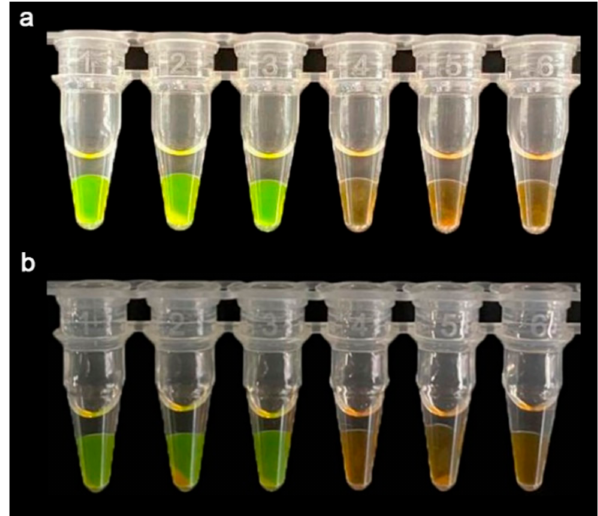
Figure 10. Loop-mediated isothermal amplification (LAMP) detection of P. graminea in barley tissues with reaction mix under different storage times. Assessment based on SYBR Green I visualization of color change. The mixed reagents A and B were stored at − 20 ◦ C for 1 d ( a ) and 7 d ( b ) and then transferred to a 4 ◦ C refrigerator for 24 h. Tubes 1 to 6, DNA templates from P. graminea (positive control), smashed seeds infected with P. graminea , infected intact seeds, healthy seeds, healthy smashed seeds, and the negative control (H 2 O).